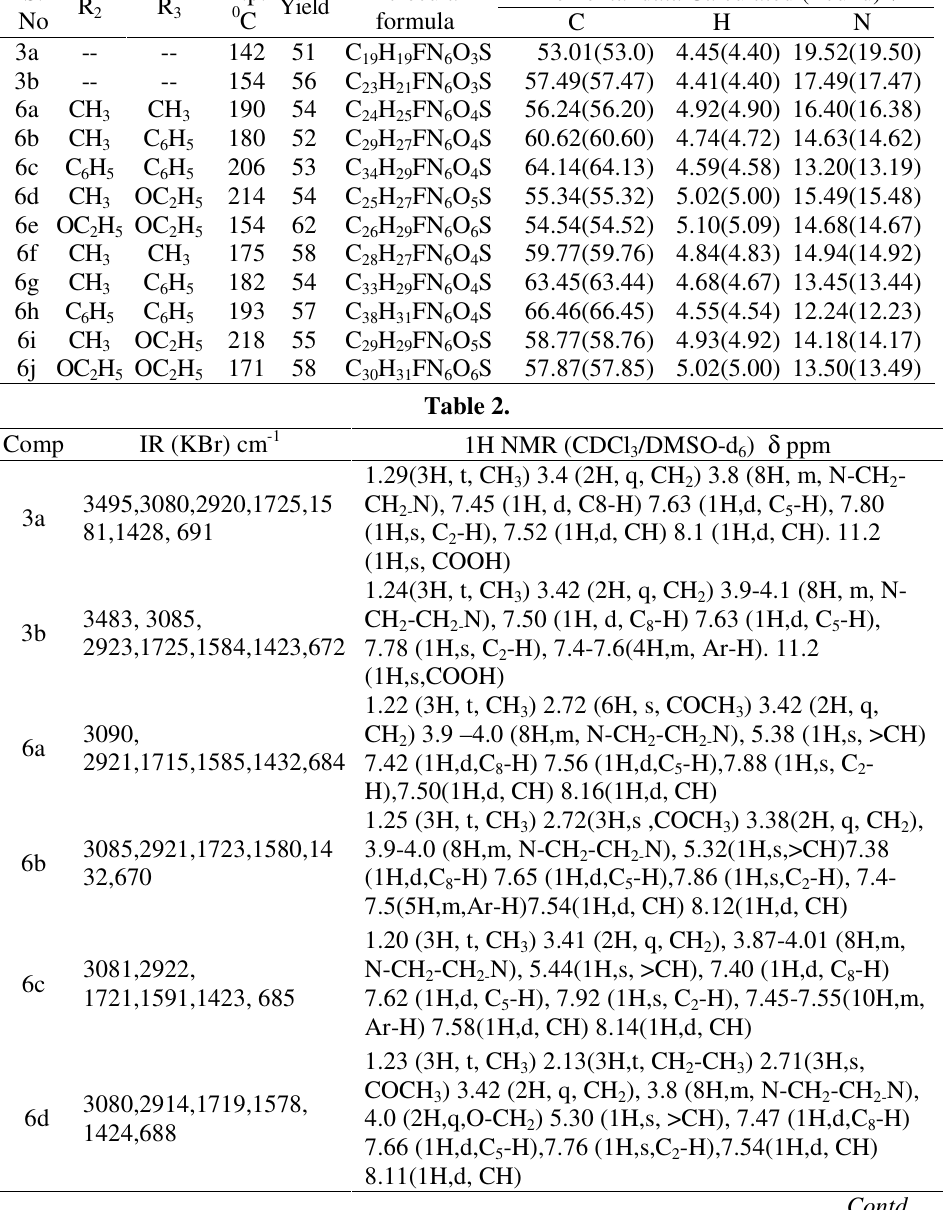
Elemental data Calculated (Found) %